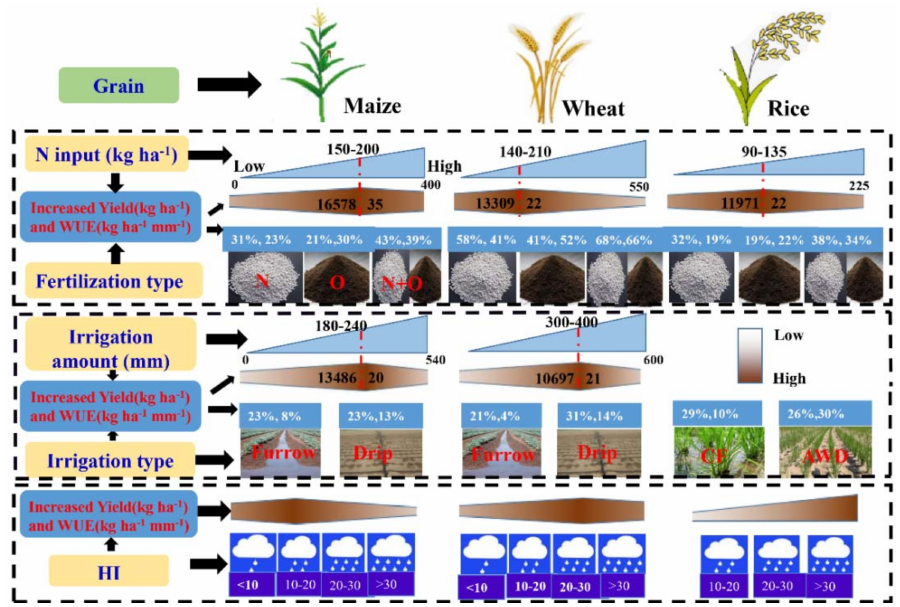
Figure 10. The effect of different agricultural management methods on crop yield and WUE of maize, wheat and rice. Abbreviations: N, nitrogen fertilizer; O, organic fertilizer; N+O, organic-inorganic mixed fertilizer; CF, continuously flooded; AWD, alternate wetting and